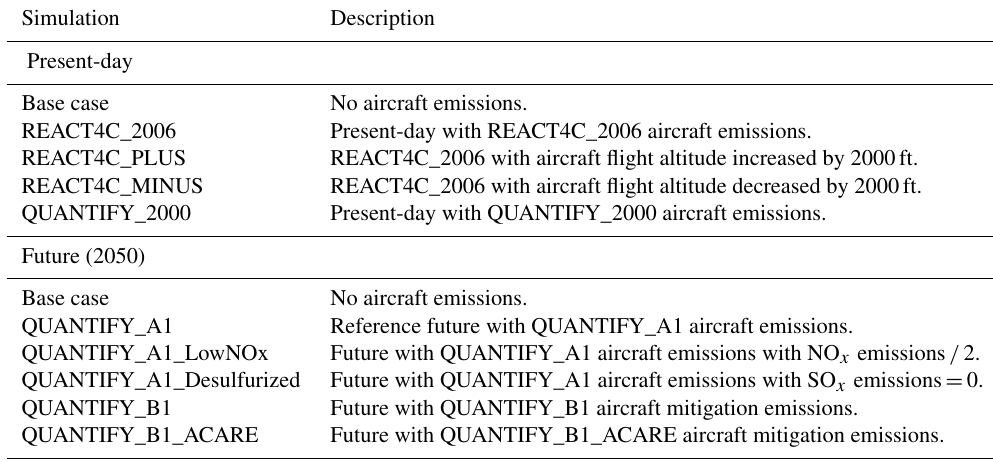
Table 3. LMDZ-INCA model simulations performed in this study. Simulation